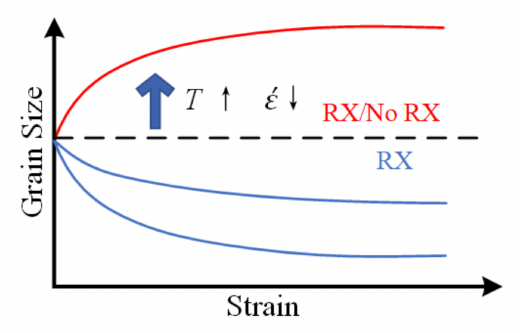
Figure 10. Schematic illustration of the evolution of grain size with strain.